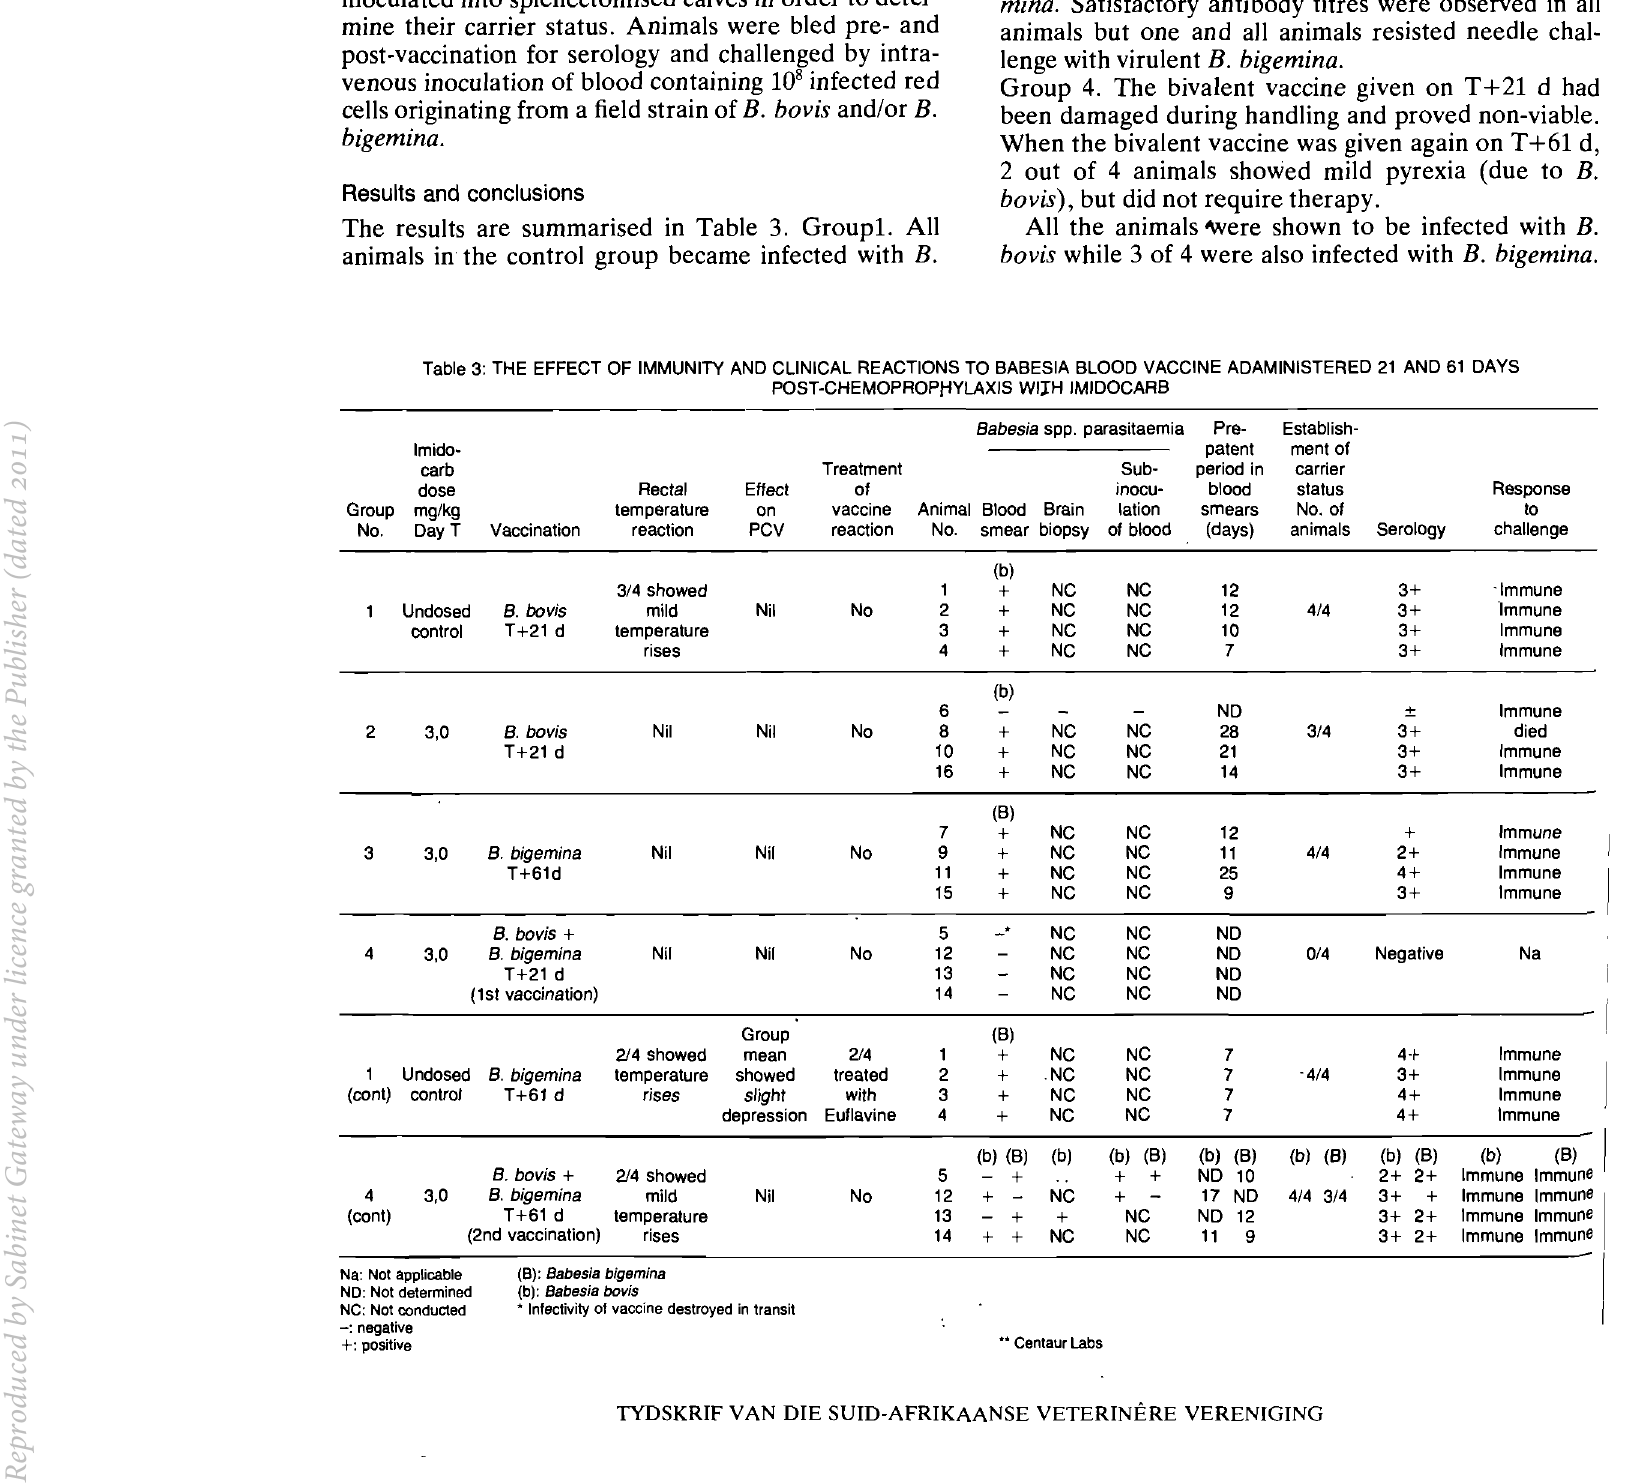
Table 3: THE EFFECT OF IMMUNITY AND CLINICAL REACTIONS TO BABESIA BLOOD VACCINE ADAMINISTERED 21 AND 61 DAYS POST-CHEMOPROPtiYLAXIS WI!H IMIDOCARB Babesia spp.